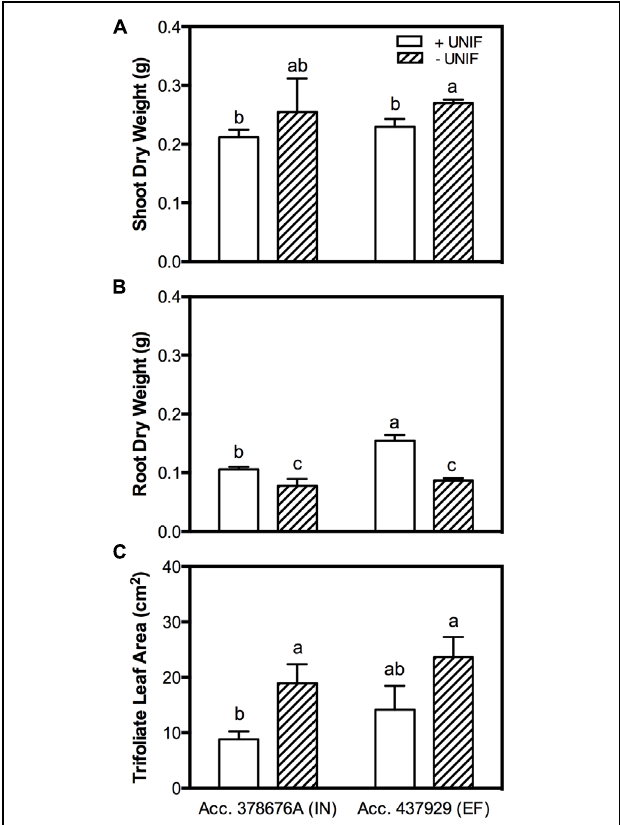
FIGURE 5 | Shoot DW (accounting the unifoliate leaves weight; (A), root DW (B) and trifoliate leaf area (C) of two G. max accessions [378676A (inefficient) and 437929 (efficient)] grown under Fe-deficient ( − Fe) hydroponic conditions, with ( + UNIF) and without ( − UNIF) unifoliate leaves (Experiment 2). Data are mean ± SE of five biological replicates. Different letters indicate significant differences ( P <